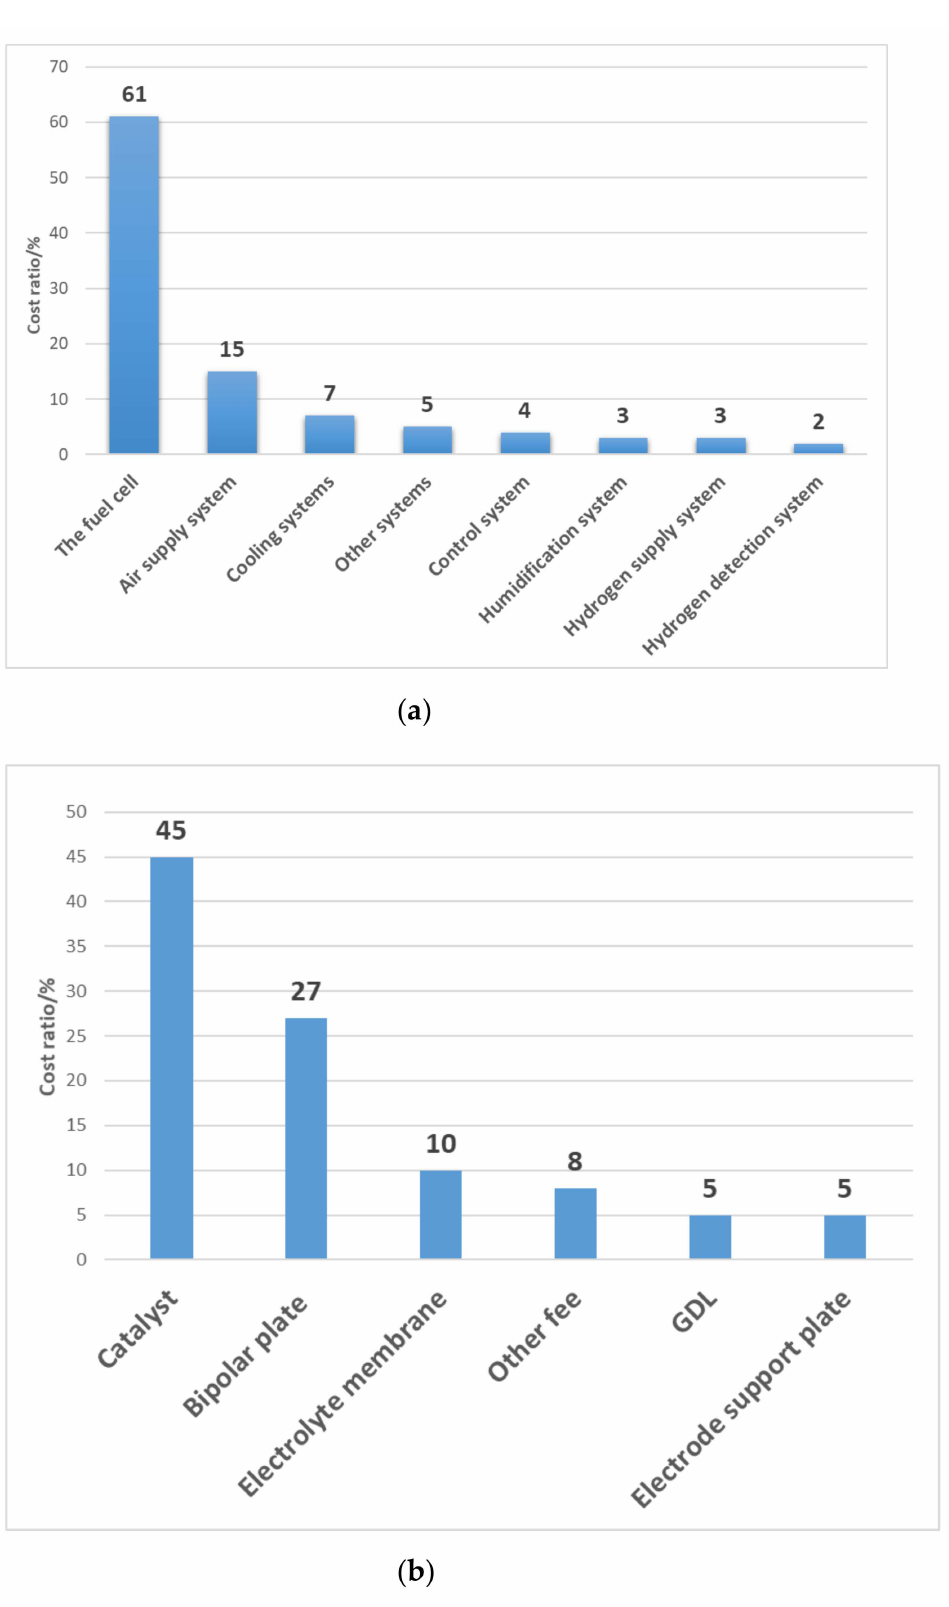
Figure 2. Cost structure of fuel cell system ( a ) and stack ( b ) [17] (Copyright 2015